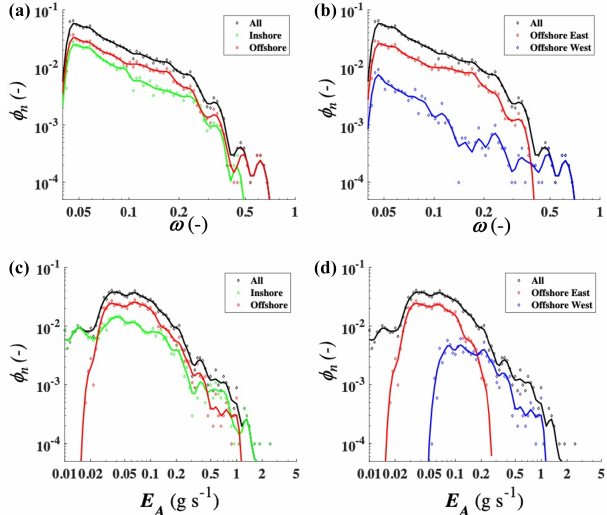
Figure 8. (a) Sonar return, ω , and occurrence probability, ϕ n (ω) , for all seepage and inshore and offshore seepage and (b) all seepage, offshore east seepage, and offshore west seepage. (c) Atmospheric emission, E A , and occurrence probability, ϕ n (E A ), for all seepage and inshore and offshore seepage and (d) all seepage, offshore east seepage, and offshore west seepage. Data key is shown in